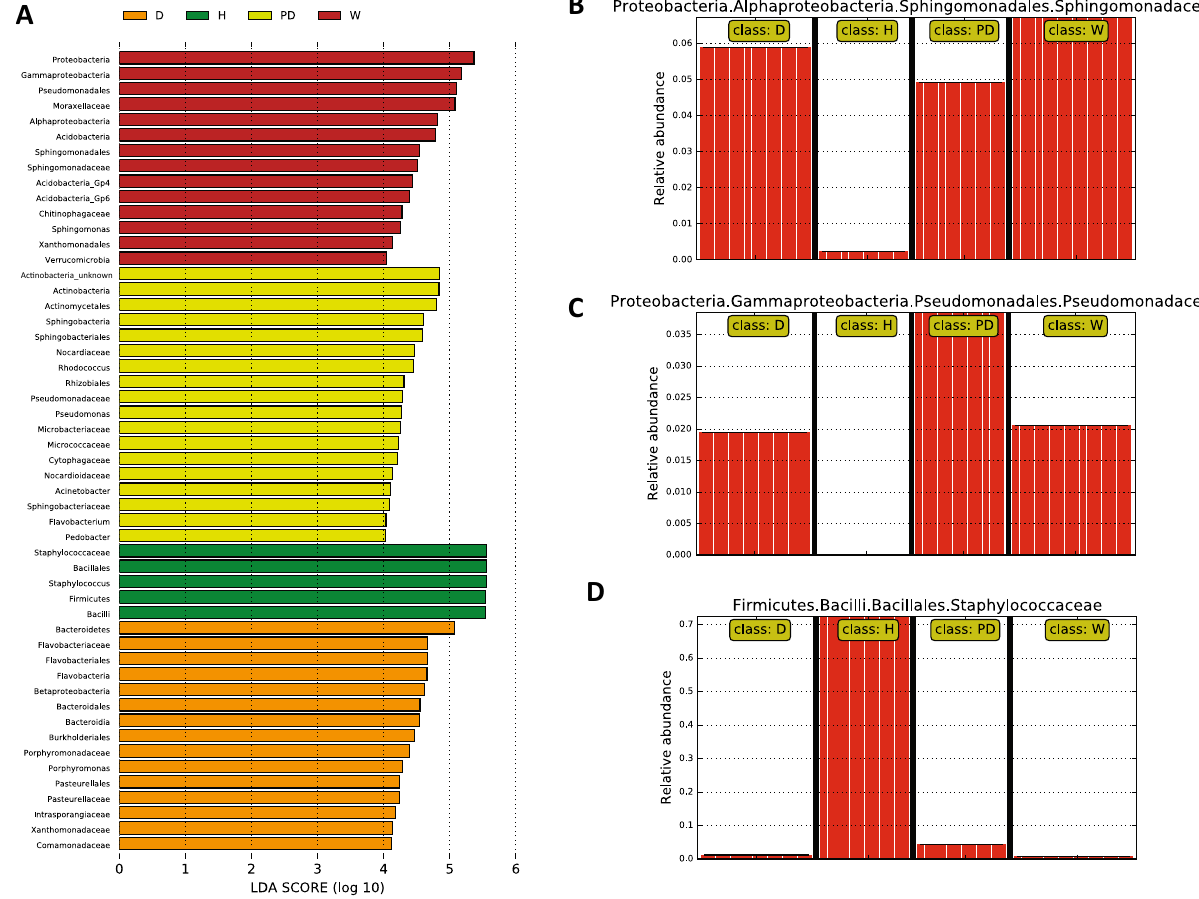
Figure 3. ( A ) LEfSe (Linear discriminant analysis Effect Size) calculation which determines features most likely to explain differences between groups, ( B – D ) LEfSe plot on differential features. H = human, PD = pet dog, D = WSC dog, W = WSC